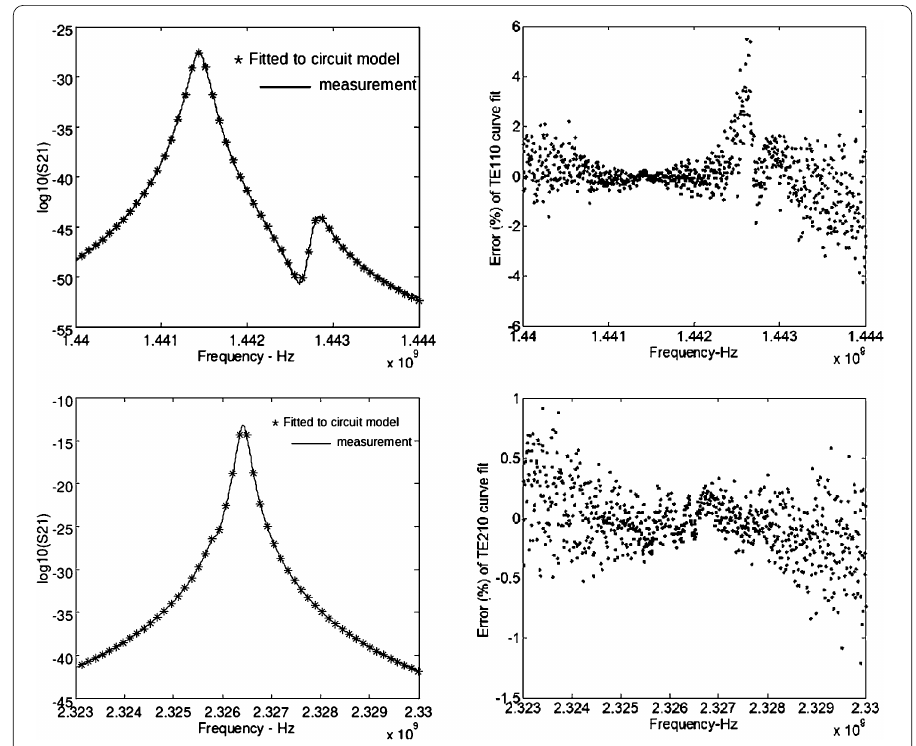
Figure 3 Result of step 1. Behavior of the Lorenzian function as a function of frequency, fitted to experimentally measured TE110 (left and right figures of the top figure) and a TE210 (left and right figures of the bottom figure) resonance in an air filled aluminium pipe of 128.5 mm internal diameter. Resonant frequencies and quality factors are extracted from a Lorentzian fit the transmission measurement. Complex TEm 10 0 , which form input to the combined resonant frequencies in (6) are calculated as ω 0 = f TEm 10 0 + i f 2 Q TEm 10 0 transverse resonant open ended coaxial waveguide functional. The top and bottom figures on the right side show the relative difference between the measured data and the Lorenzian function.